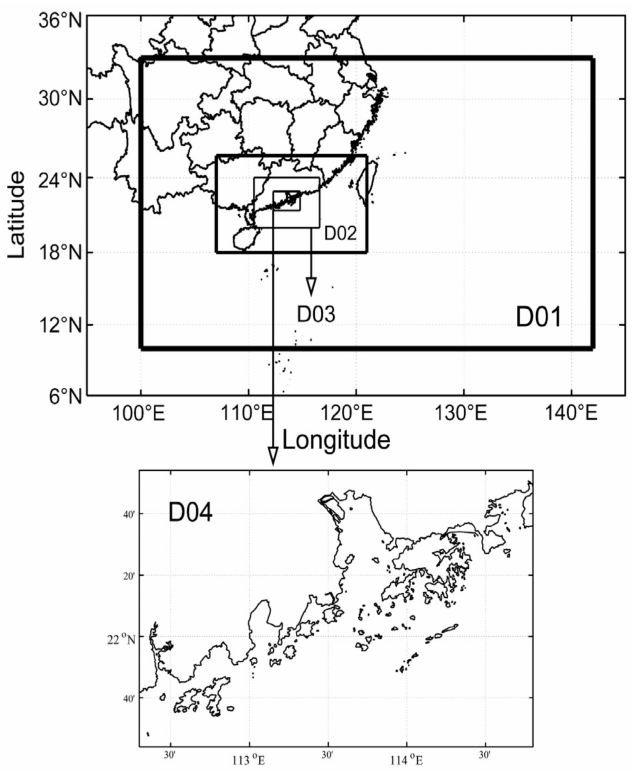
Figure 1. Nested-domain configuration with WRF